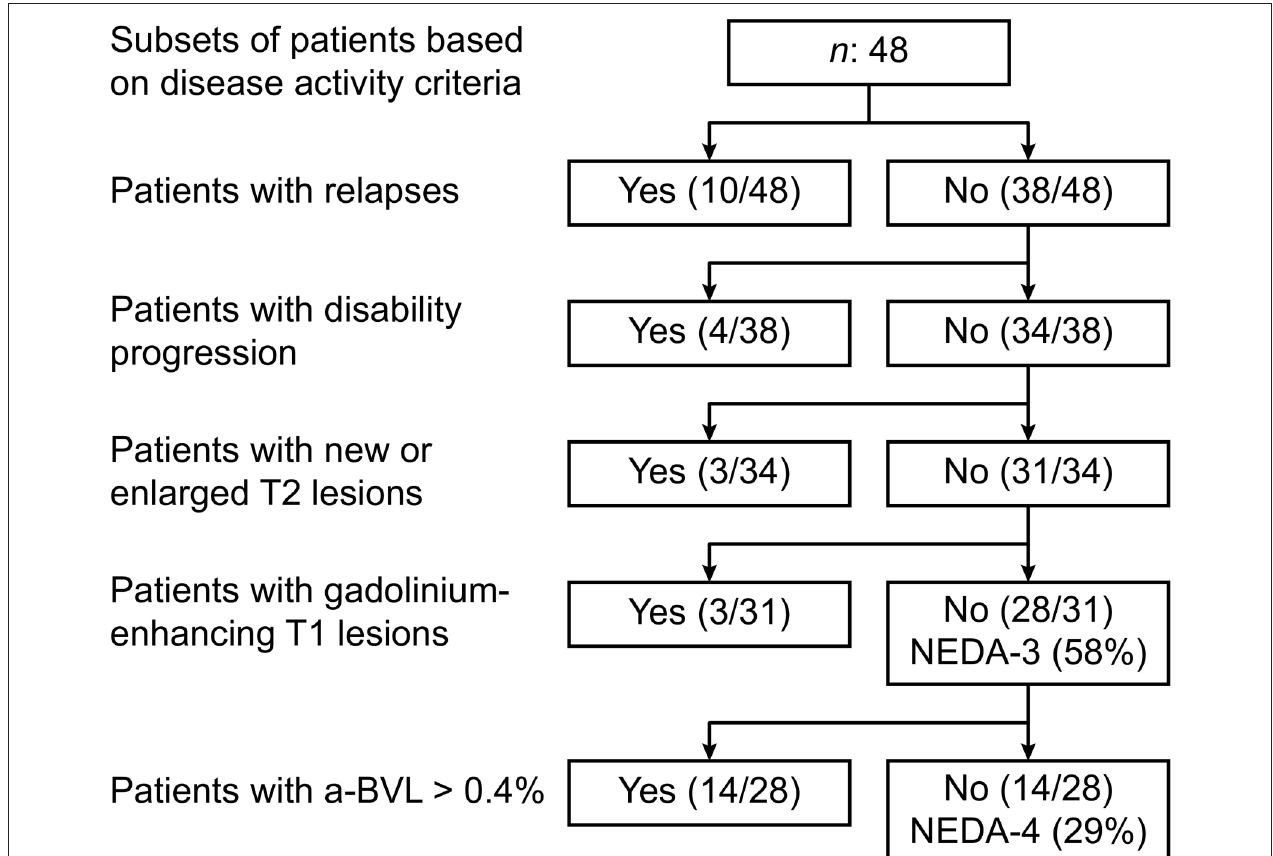
FIGURE 1 | Hierarchical analysis of individual disease activity